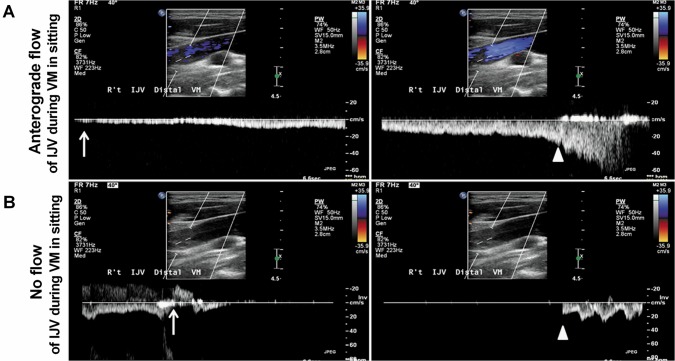
Display of Doppler spectra in IJV (internal jugular vein) during VM (Valsalva maneuver) in sitting.(A) Patient 1. Anterograde flow in right IJV during VM in sitting (upper panel, A) suggests the pressure can be released by the reopening IJV in a 42-year-old healthy woman with IJV patency. (B)Patient 2. No flow in right IJV during VM in sitting (lower panel, B)with transient venous reflux (arrow, B) indicates the intracranial venous pressure can’t be effectively relieved through the reopening of the IJV in a 53-year-old TGA patient with significant IJV stenosis/obstruction. Arrows indicate beginning of VM, arrowheads indicate end of VM.